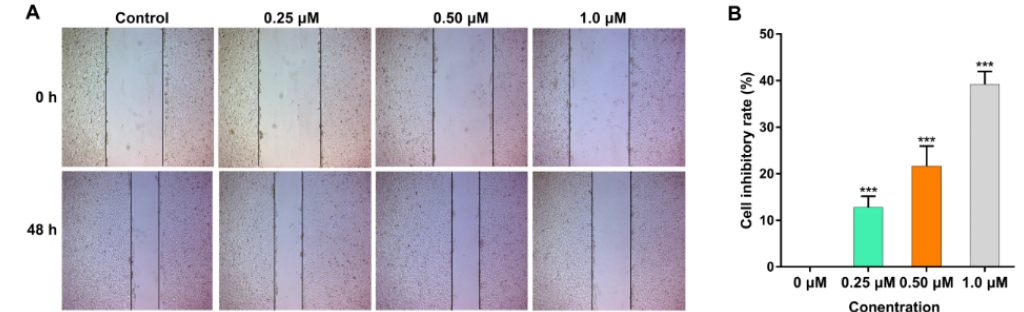
Figure 5. Compound 7a inhibited migration of HepG2 cells. ( A ) Compound 7a decreased the HepG2 cell motility compared to the control group. ( B ) Data are expressed as means ± SD of cell inhibitory rate (%) for the migration of HepG2 cells from three independent experiments. Statistical significance is determined by two-tailed Student t-test: “***” denote p < 0.001 (Supplementary Table S4).